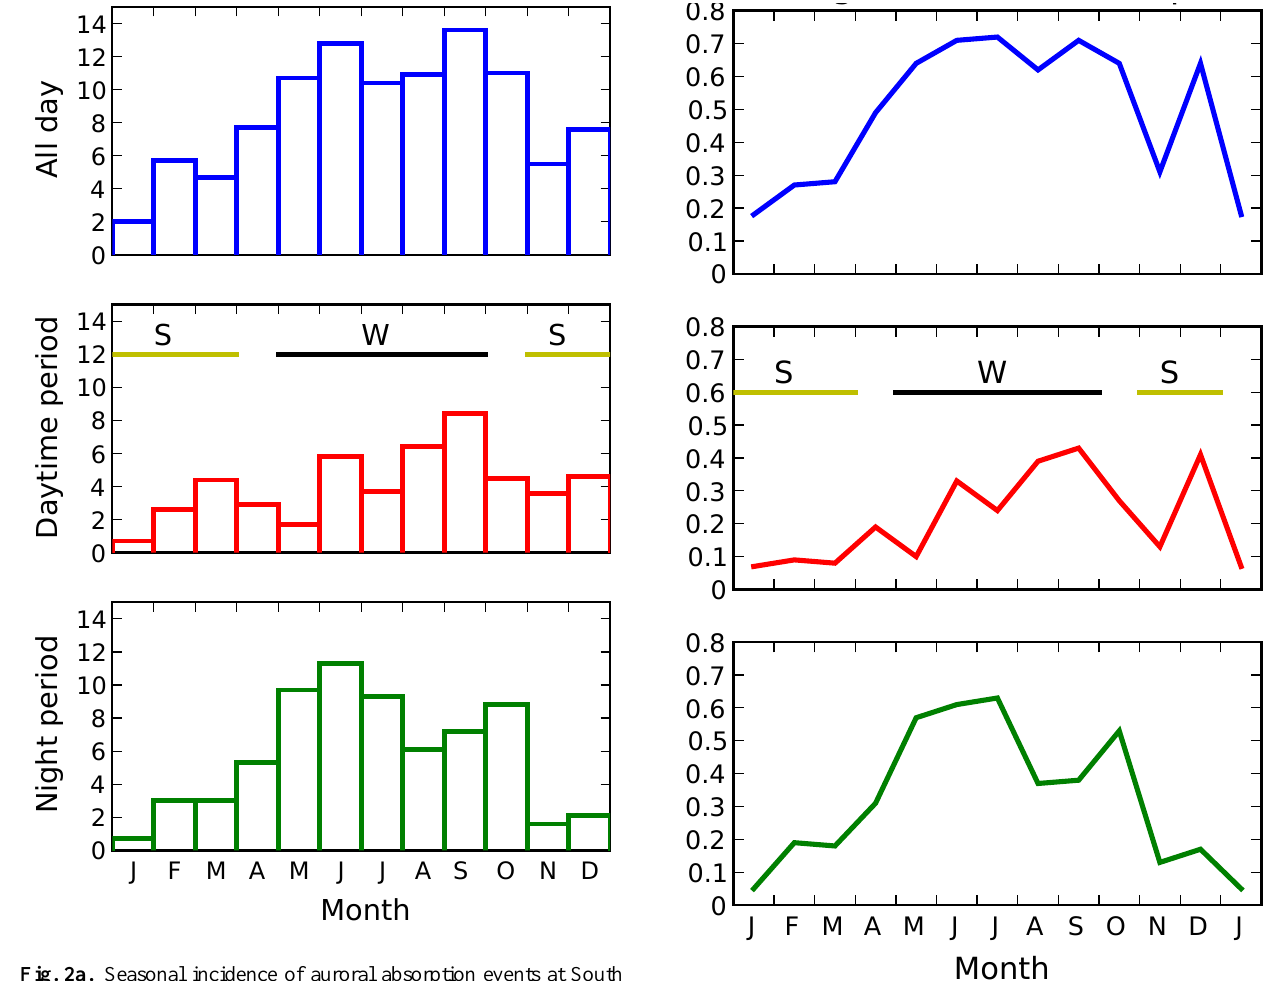
Fig. 2a. Seasonal incidence of auroral absorption events at South Pole over the whole day and within the day and night periods de- fined in Fig. 1. The plot shows the number of days per year hav- ing at least one absorption event exceeding the threshold in a given month. The data have been corrected to a uniform “30-day month”. Summer and winter periods are marked.